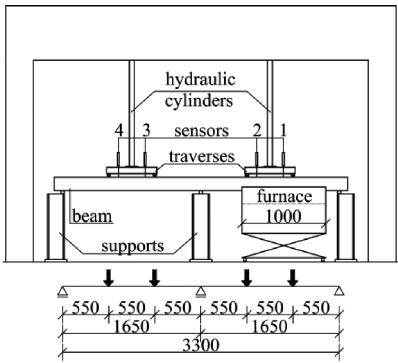
Fig. 2. Diagram of the experimental setup